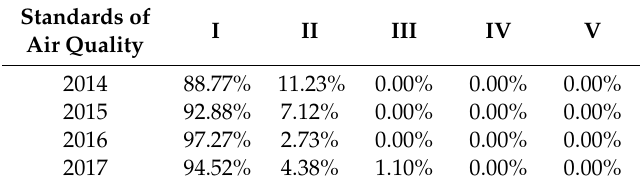
Table 2. Percentage of urban air quality standards for 2014–2017 in Wuyishan